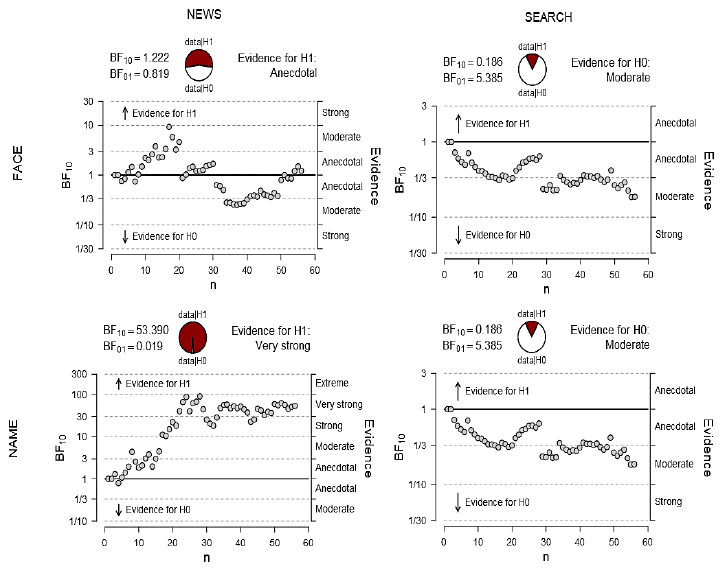
Figure 5. Scatter plot correlation for the face and name conditions under Google frequencies on searches and